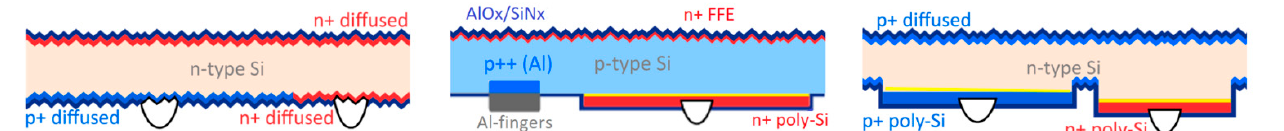
Figure 2. Cross sections of 3 major different IBC cell concepts with no, one and two carrier-selective contacts. Red colour represents n-type doped regions, blue p-type doped and yellow a thin tunnelling oxide.